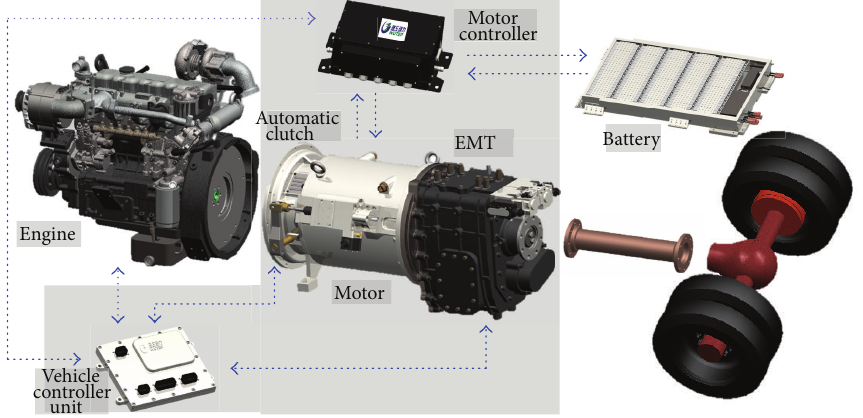
Figure 1: Structure diagram of a parallel PHEB powertrain with EMT.